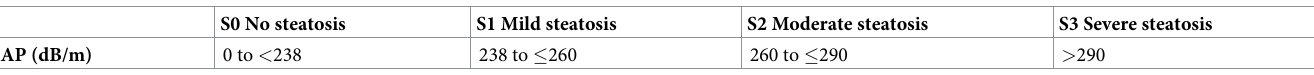
Table 2. Controlled attenuation parameter (CAP)